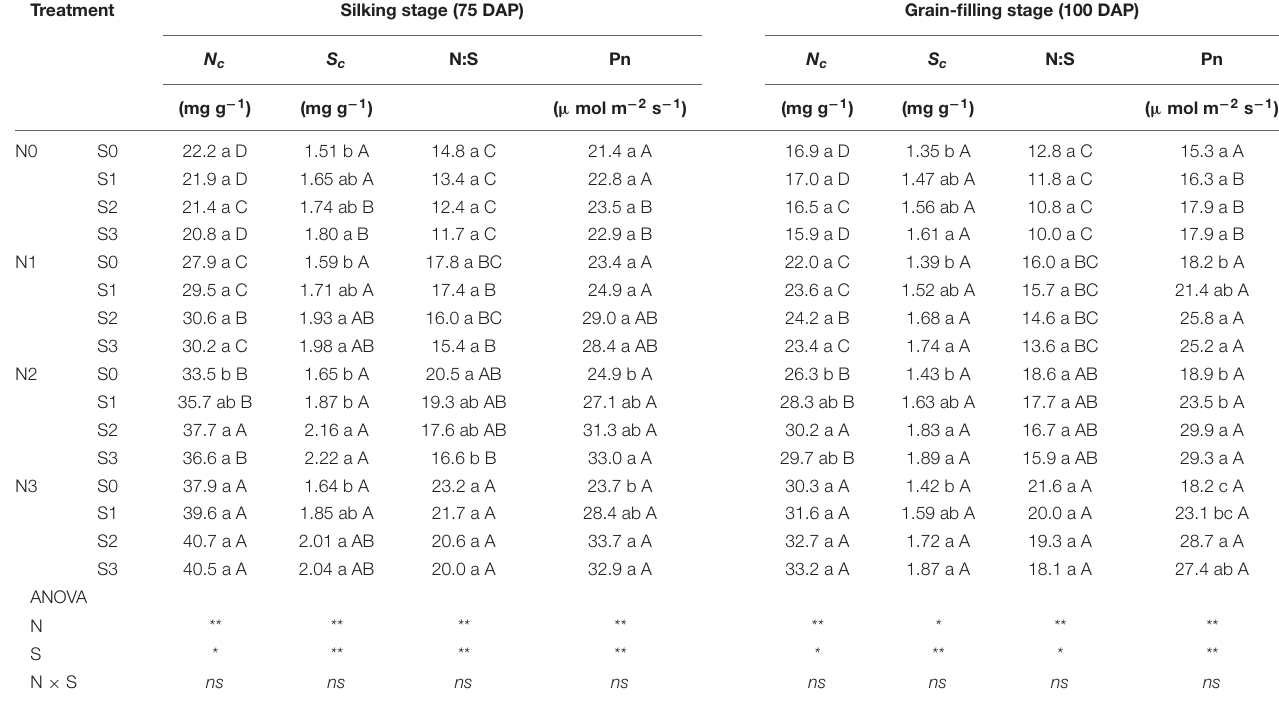
TABLE 1 | N and S stoichiometry and photosynthetic rate in maize leaves of different growth stages.